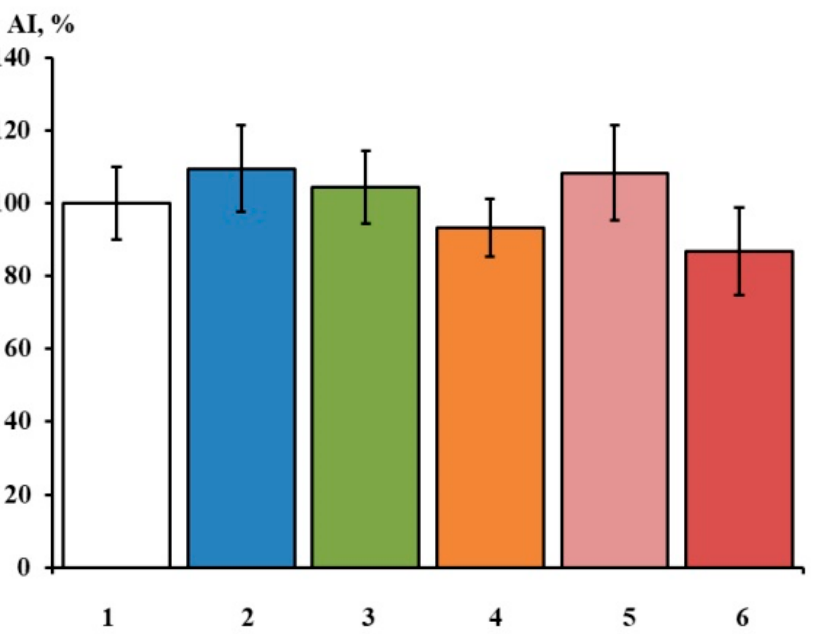
Figure 4. Effects of arginine-containing short peptides on neurite growth in DRG explants in control conditions (1) AI = 100 ± 10% (n = 20) and after the application of 100 nM peptides: (2) Ac-PRERRA- NH 2 AI = 110 ± 12%, (3) Ac-PRARRA-NH 2 AI = 105 ± 10%, (4) Ac-RAR-NH 2 AI = 93 ± 8%, (5) Ac-RAAR-NH 2 AI = 108 ± 13%, (6) Ac-REAAR-NH 2 AI = 89 ± 12%. The ordinate axis—area index (AI, %). Data are presented as mean ± SEM (not significant, p > 0.5) (n = 16–26).